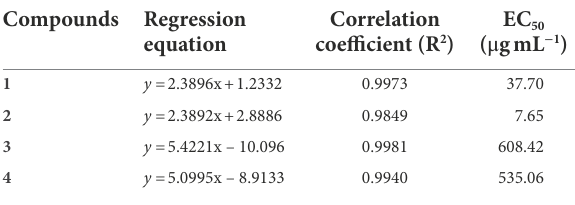
TABLE 1 Antifungal activity against B. cinerea of compounds